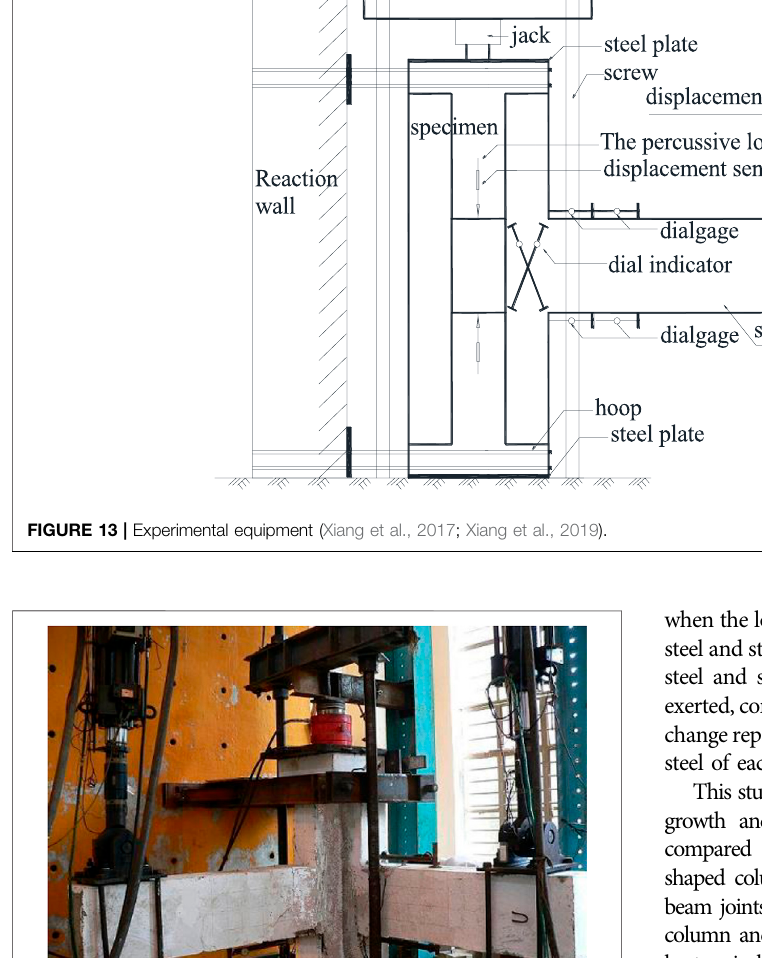
Frontiers in Materials |